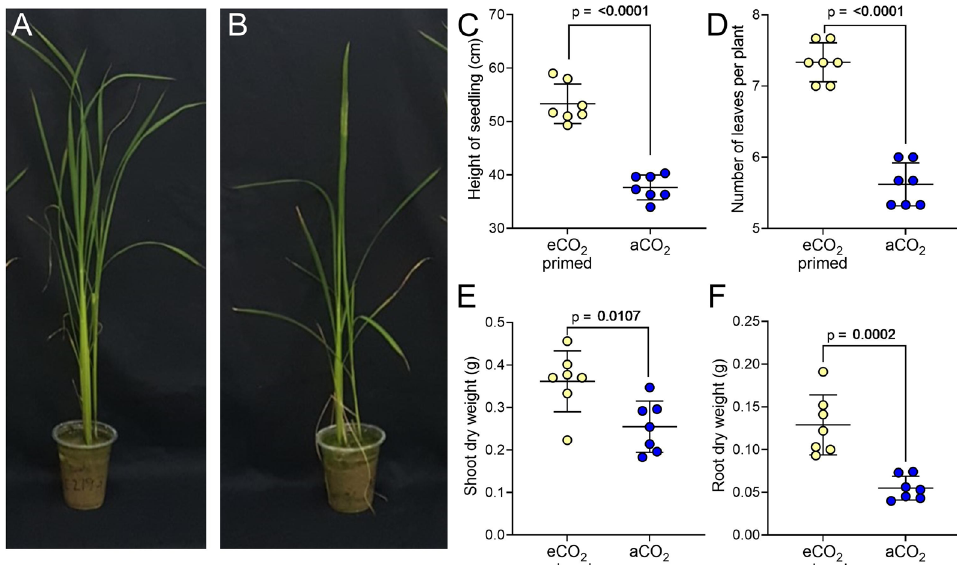
Fig. 2 Rice seedling growth is increased in a yeast eCO 2 propagator. MR219 seedlings 24 DAS grown A in a yeast eCO 2 propagator and B at aCO 2 . C – F For seedlings harvested at 24 DAS, seedling height ( C ); leaf number ( D ); shoot dry weight ( E ) and root dry weight ( F ) are significantly higher in eCO 2 grown plants. C – F unpaired t test, p values as shown, n 7. For C , D each point is the mean of 3 =